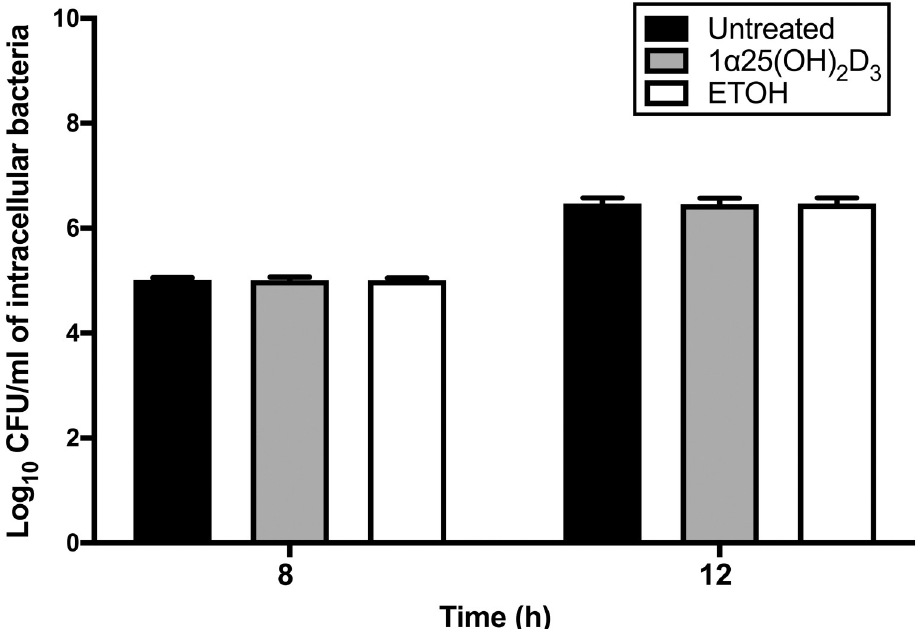
Fig 4. Effect of 1 α ,25(OH) 2 D 3 pretreatment of A549 cells on B . pseudomallei multiplication. The 1 α ,25(OH) 2 D 3 - pretreated A549 cells were incubated with B . pseudomallei H777. Bacterial multiplication was determined using the plate count technique. The results are shown as mean ± SD from three independent experiments carried out in triplicate.